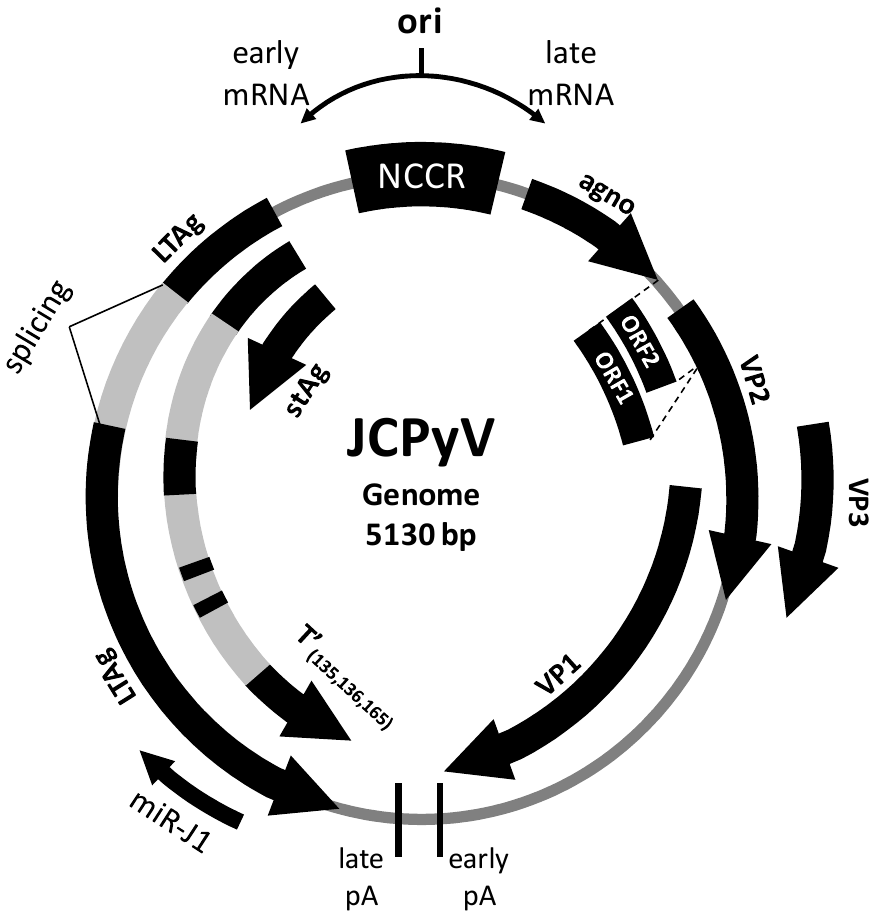
Figure 1. Genomic organization of the polyomavirus JC (JCPyV). ori: origin of replication region; NCCR: non-coding control region; LTAg: large T-Antigen; sTAg: small T-antigen; T’ (135,136,165) : T-antigen splice variants [15,16]; VP1-3: major capsid proteins; Agno: Agnoprotein (agno); pA: polyadenylation site; ORF: open reading frame [17,18].